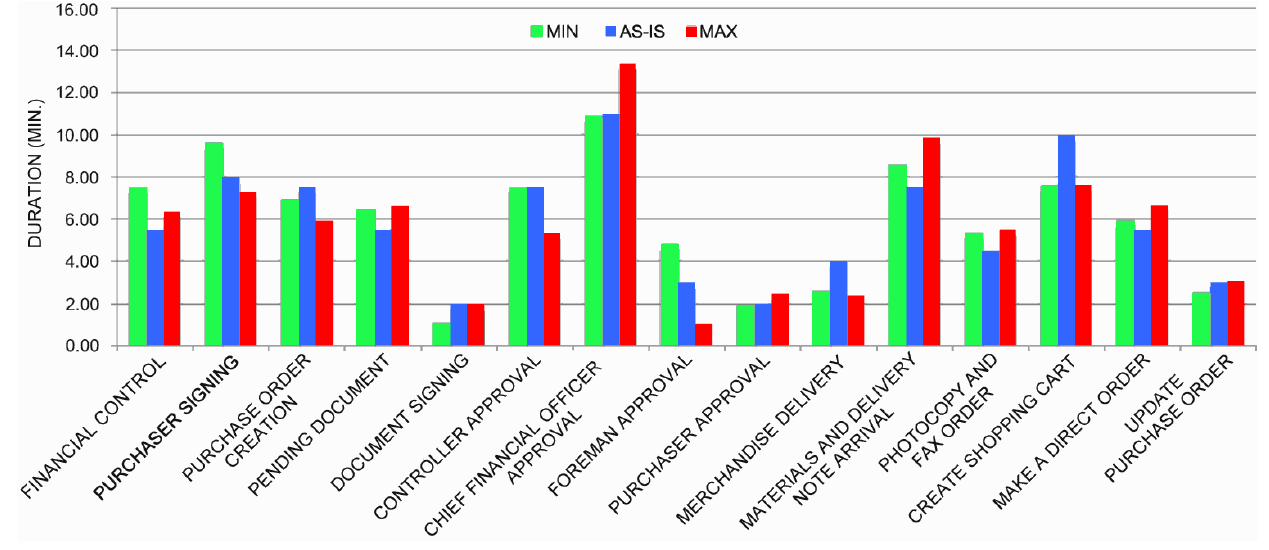
Figure 18. Duration of the relevant tasks, in the minimum KPI, as-is and maximum KPI